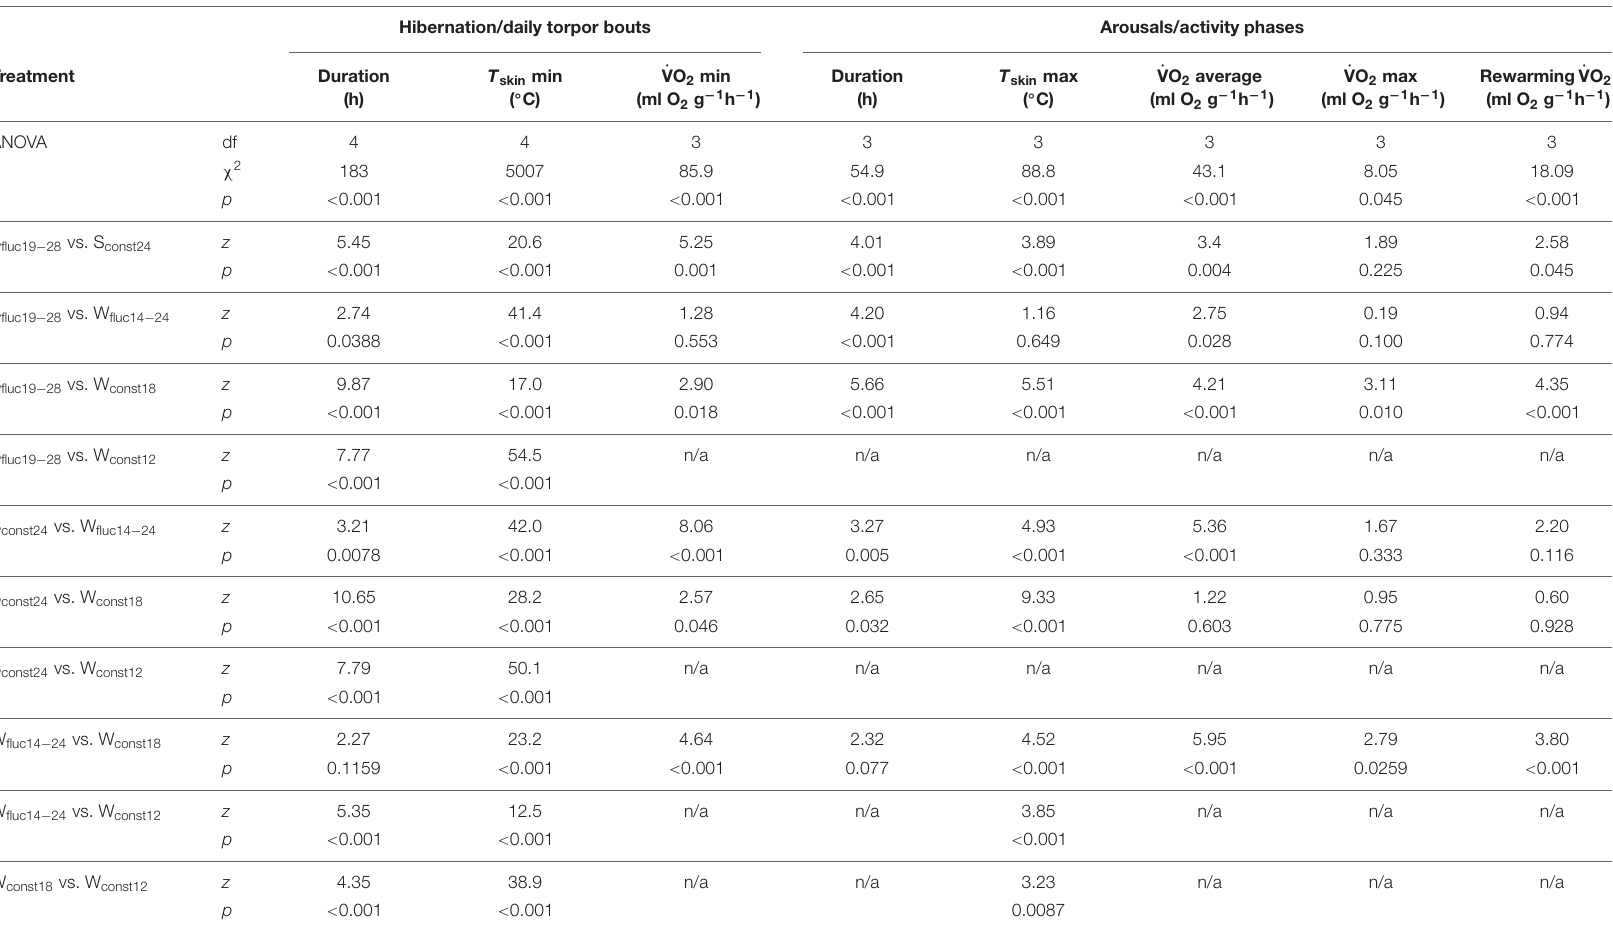
TABLE 2 | Statistical parameters for ANOVA and Tukey post hoc tests for torpor and arousal/activity phase characteristics of Echinops telfairi for all five experimental